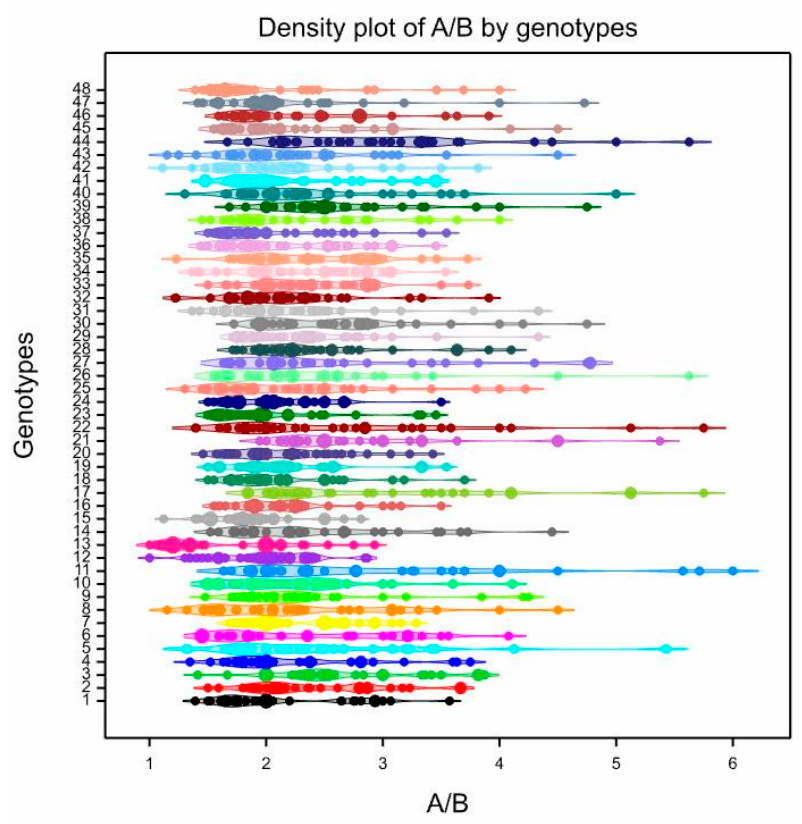
Figure 8. The density plot for the distribution of the average width of the saccus and average length ratio (A / B), classified by Abies alba genotypes. Numbers from 1 to 48, see Table